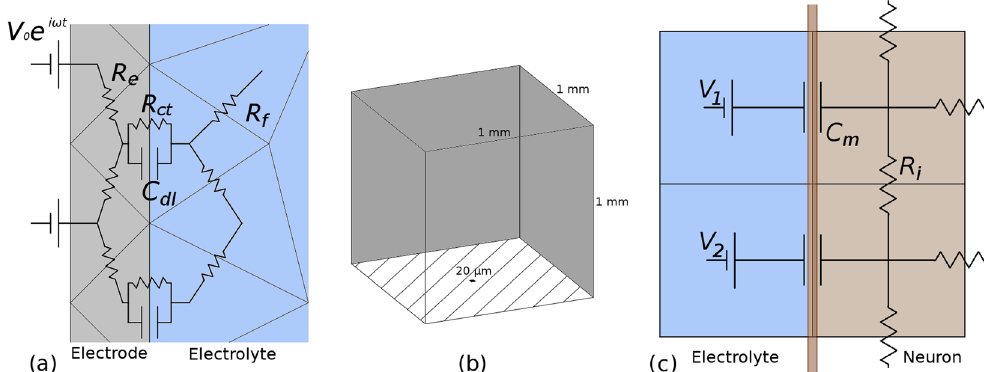
Figure 7. ( a ) Equivalent circuit model with tetrahedral nodes for an electrode surrounded by a conducting electrolyte. ( b ) Boundary conditions for the bounding domain were set to V = 0 V on the 5 surfaces far from the center electrode (dark grey) and insulating on the bottom surface (striped). The 20 µ m electrode (black) sits on the bottom surface. ( c ) Equivalent circuit model with cubic nodes for a neuron in an electrolyte undergoing high frequency stimulation. The external potential obtained from the electrode-electrolyte simulations was mapped onto the corresponding extracellular neural node, for example, V 1 and V 2